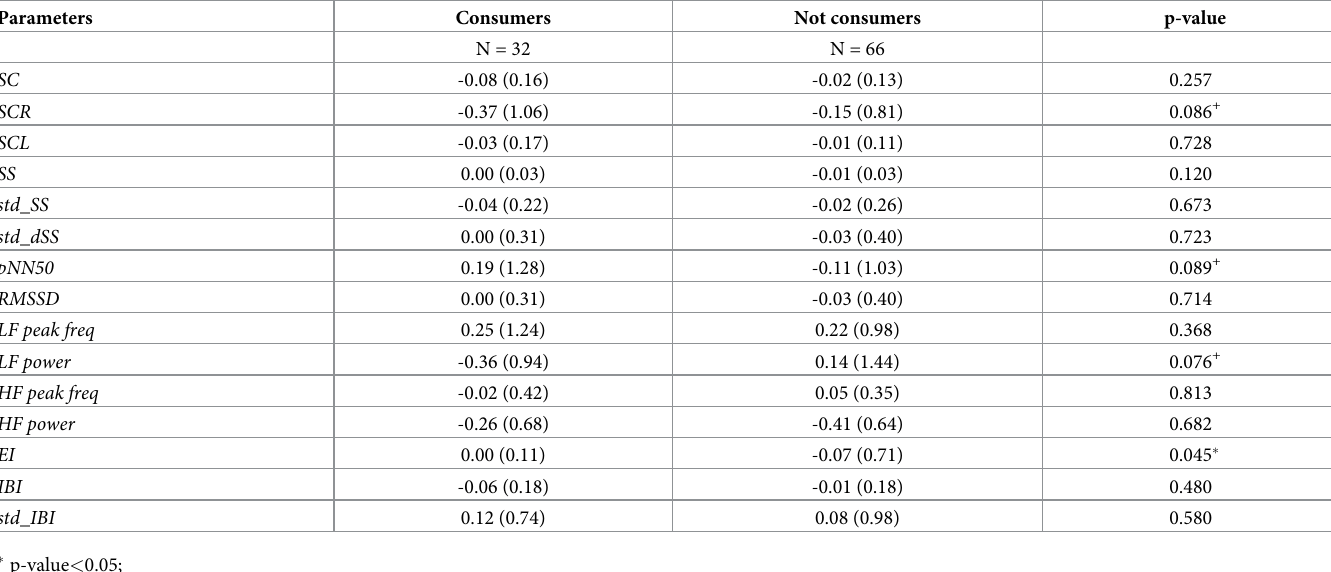
Table 5. Comparison between Coca-Cola consumers and not